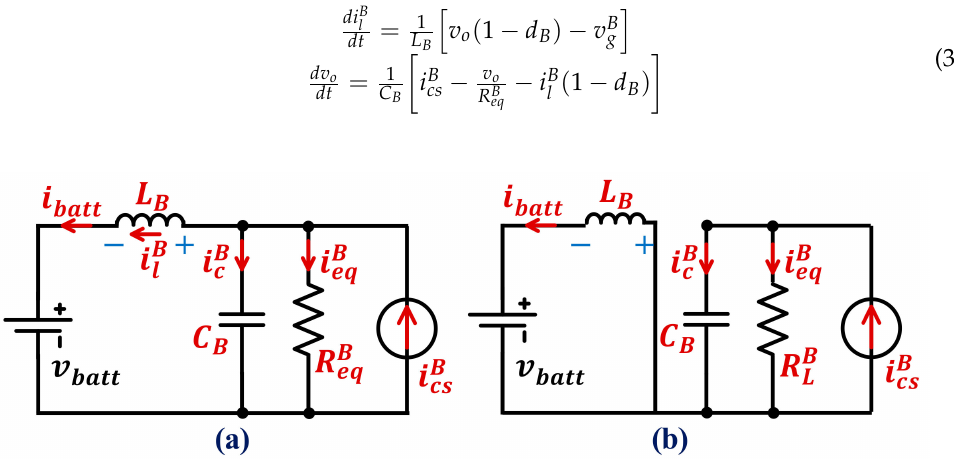
Figure 12. DC/DC bidirectional converter analysis during charging mode when: ( a ) Q2 is ON state, ( b ) Q2 is OFF